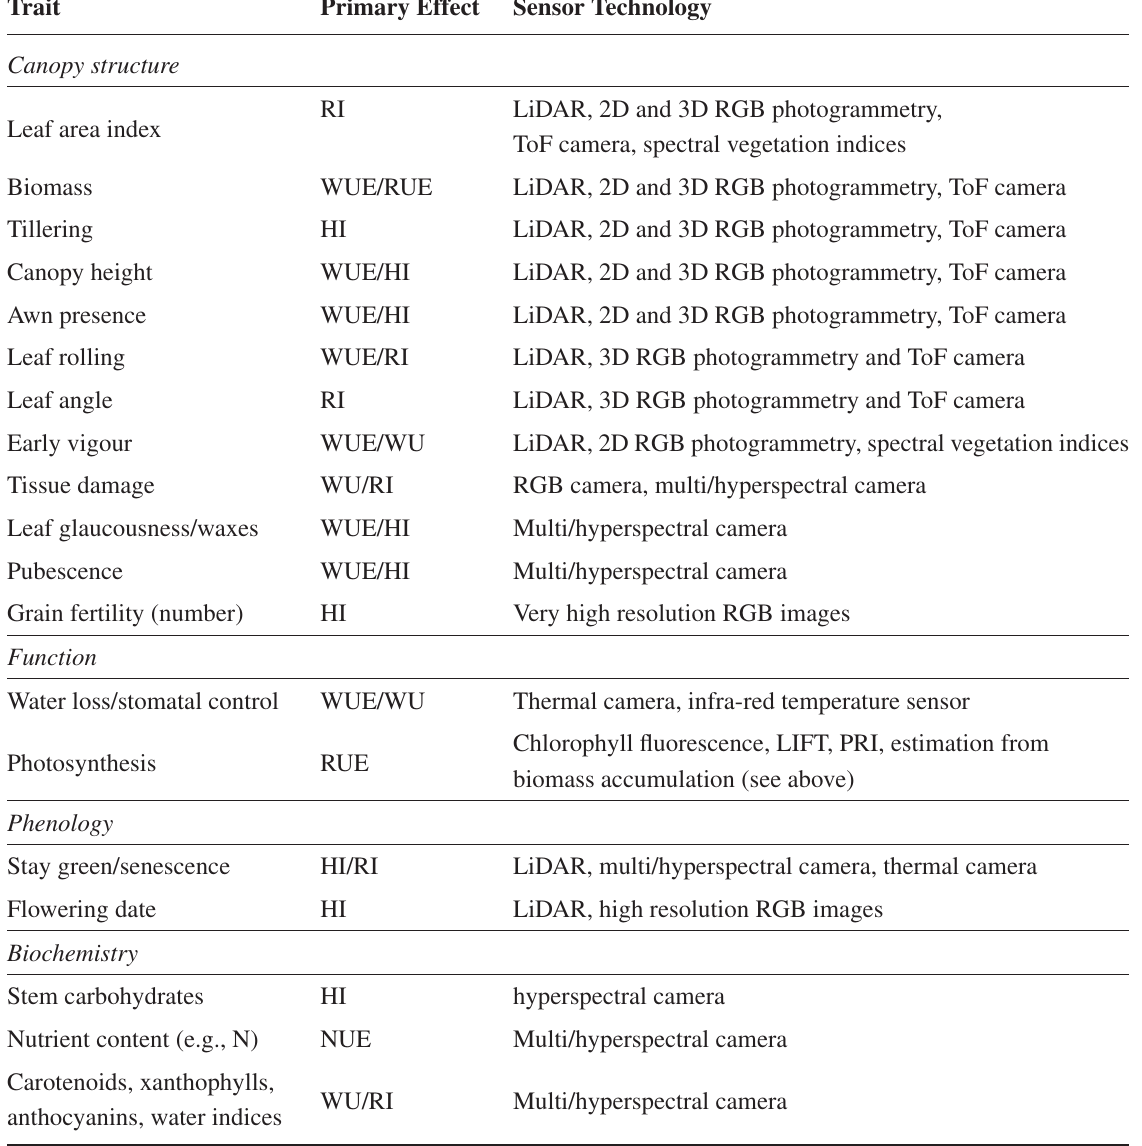
Table 3. The summary of cereal traits quantifiable with sensors mounted on field buggies and the primary effect contributing to